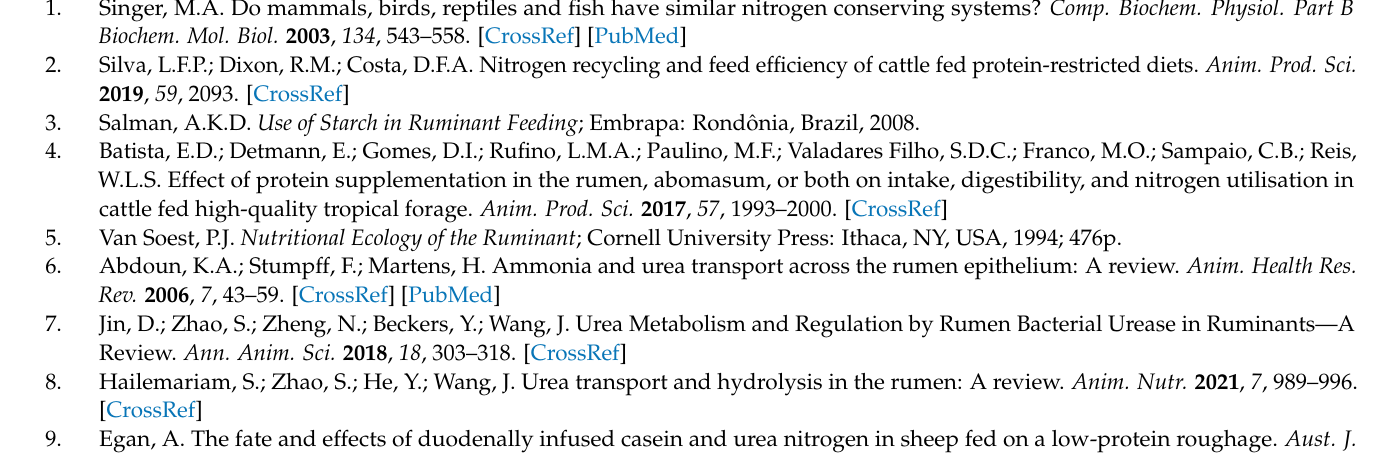
Table S3: Median and IQR of ruminal archaea and bacterial abundance at genera level influenced